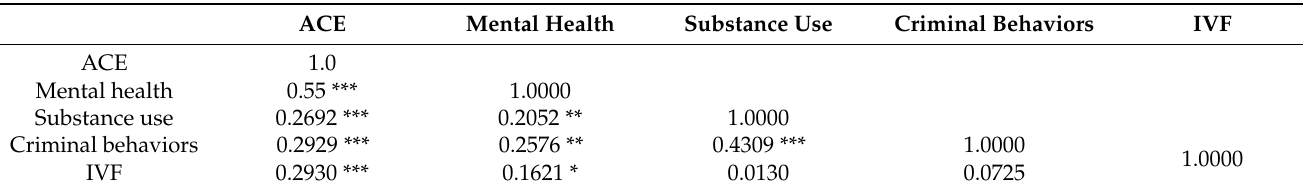
Table 4. Correlation between ACEs and consequences for mental health, criminal behaviors, alcohol and/or substance use, and IFV in the full sample.